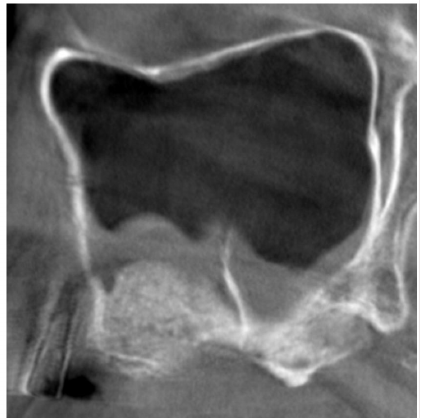
Figure 3. Lateral view of the case in Figure 1, 1 week after the sinus floor elevation. The sinus mucosa showed an increase in dimensions above anteriorly and posteriorly the septum.